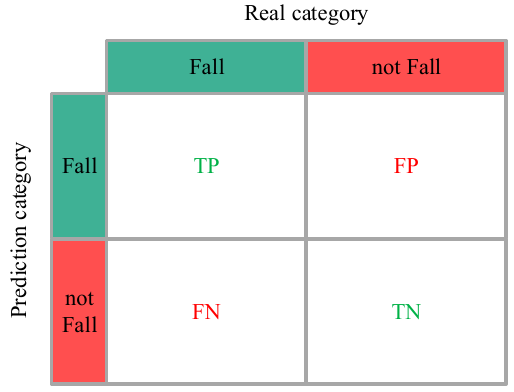
Figure 15. 2D confusion matrix of fall. (TP, FP, FN, and TN represent True Positives, False Positives, False Negatives, and True Negatives, respectively.).